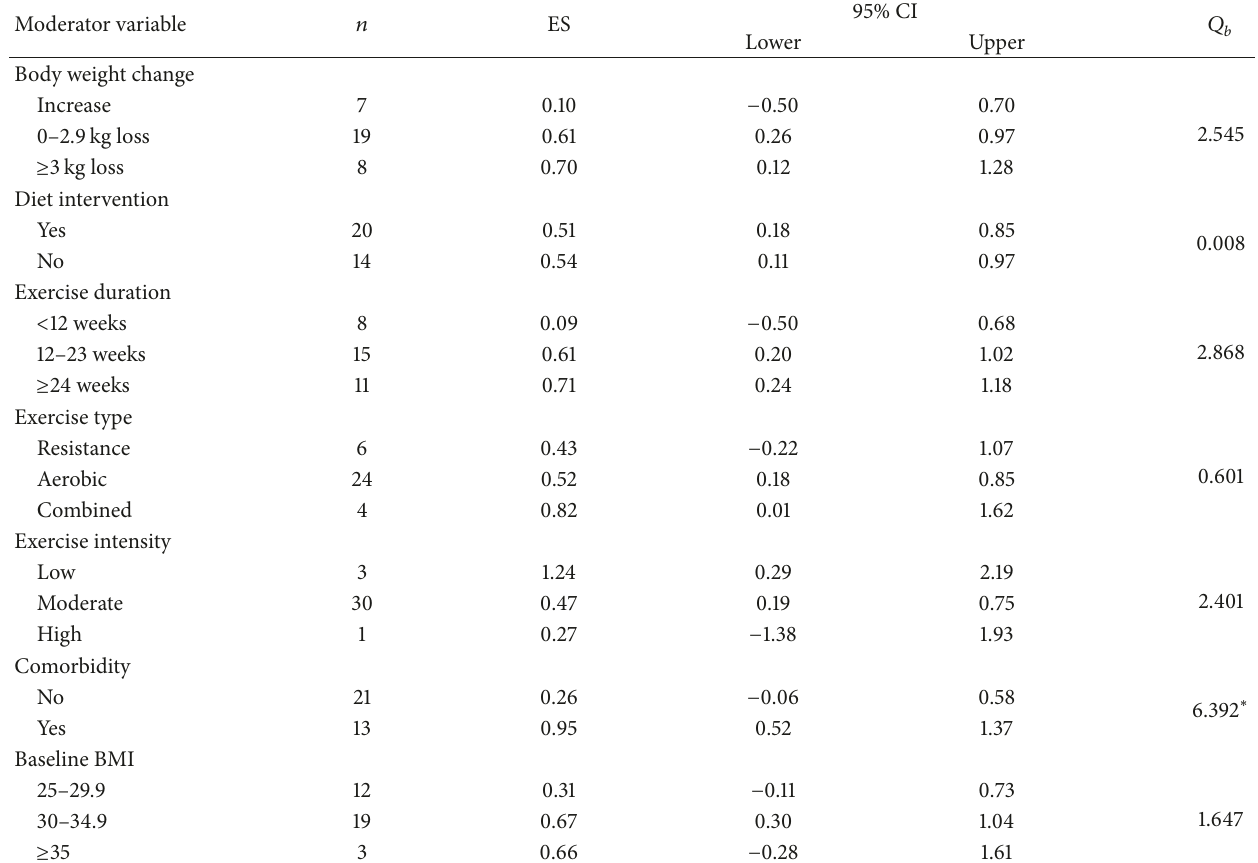
Table 5: Subgroup